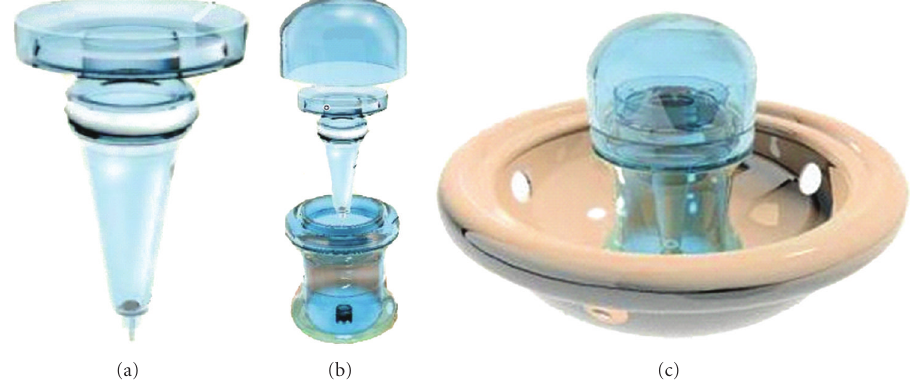
Figure 1: Component parts of the INVOcell device. (a) Inner chamber. (b) Outer rigid shell. (c) Assembled INVOcell device with its retention